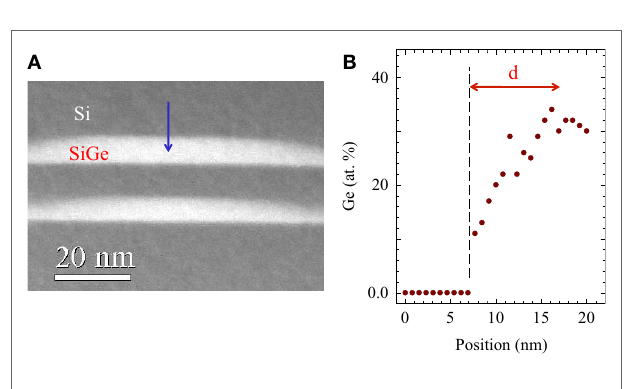
FiGURe 11 | (A) A high angle annular dark-field scanning transmission electron microscope (HAADF-STEM) micrograph showing the first and second bottom SiGe cluster layers (counting from the Si substrate) and EDX scan position (arrow). (B) EDX measured Ge atomic concentration at the second bottom Si/SiGe cluster layer heterointerface. The interface abruptness d (which is the distance between pure Si and SiGe with the nominal Ge concentration) is indicated (Modi et al., 2012a).